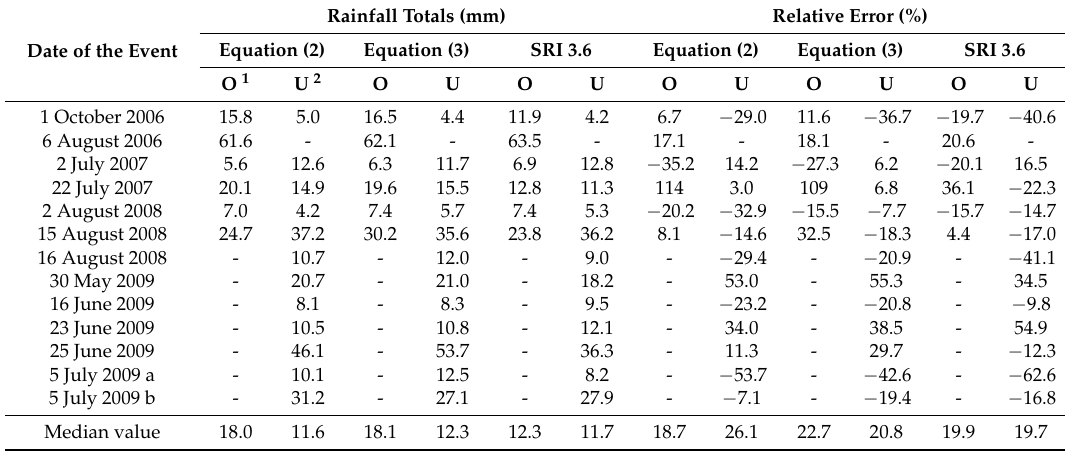
Table 2. Rainfall totals using rain gauges and SRI product